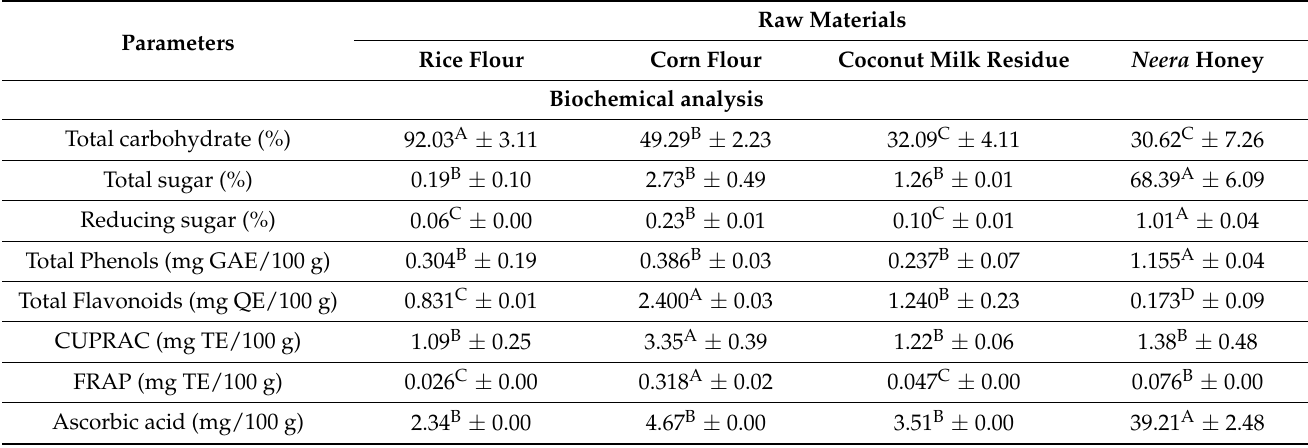
Table 3. Biochemical composition of raw materials used for the preparation of